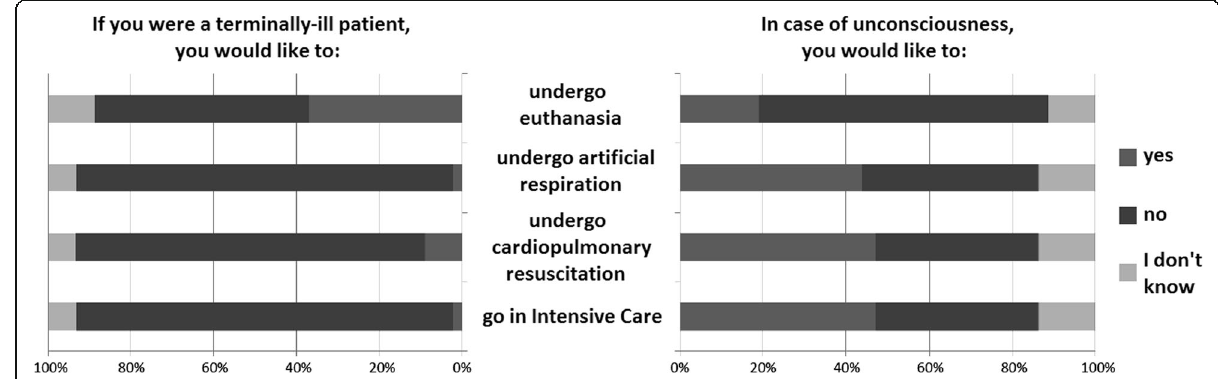
Fig. 4 Graph of Personal wishes of health professionals about and of life. Legend: Percentage of answeres related to related to different